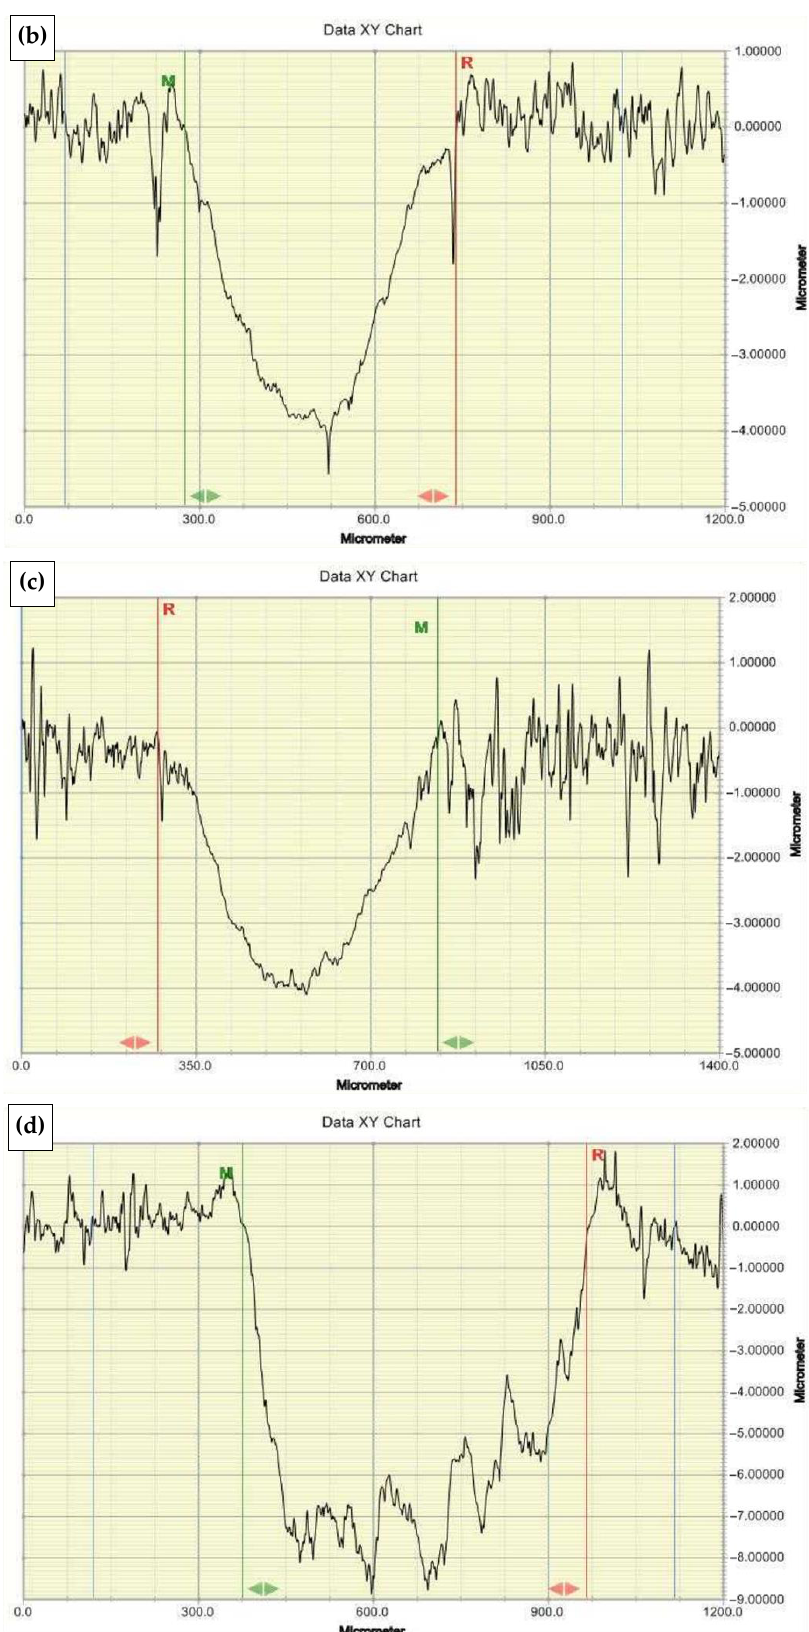
Figure 10. Selected cross-sections of surface wear profiles of Nylon and Tecamid 6 specimens: ( a ) Nylon dry sliding; ( b ) Nylon wet sliding 50 ◦ C; ( c ) Tecamid 6 dry sliding; ( d ) Tecamid wet sliding 50 ◦